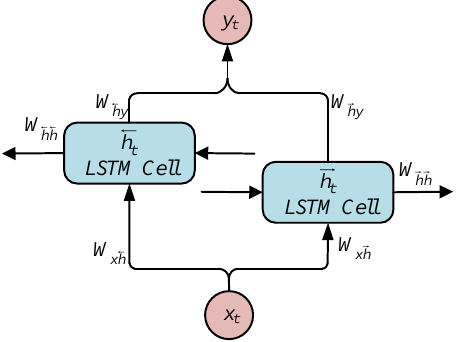
Figure 9. Structure of Bi-LSTM